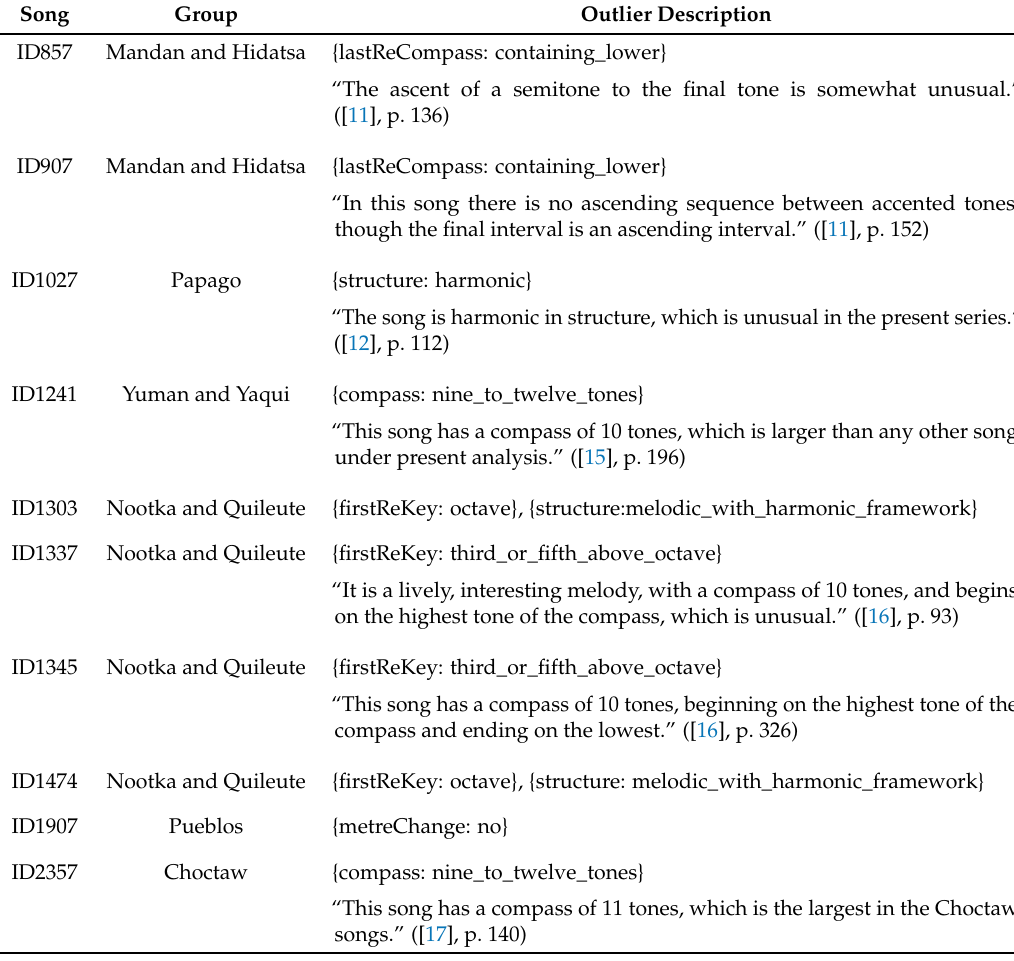
Table 4. Outliers in the Densmore collection, with related observations by Densmore where available. Outlier